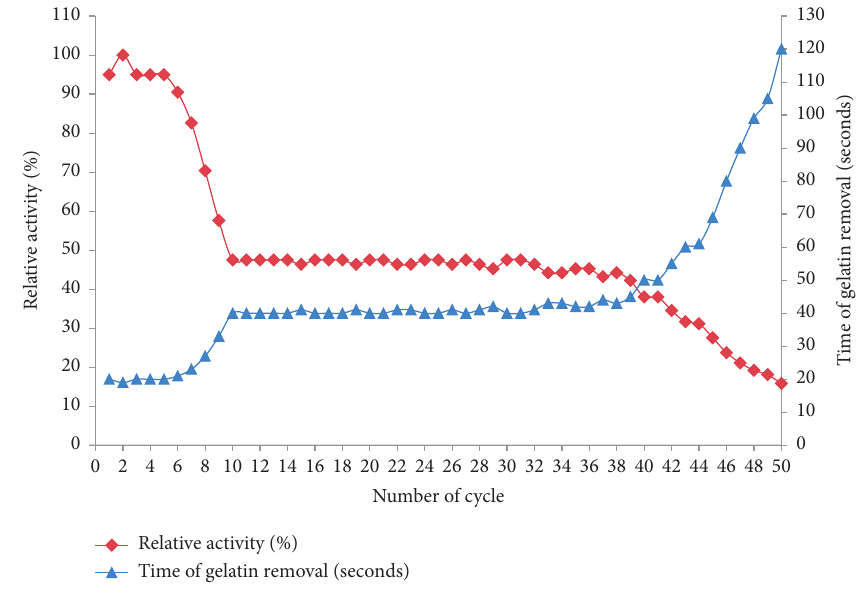
Figure 7: Reusability of crude bromelain for gelatin hydrolysis from waste X-ray